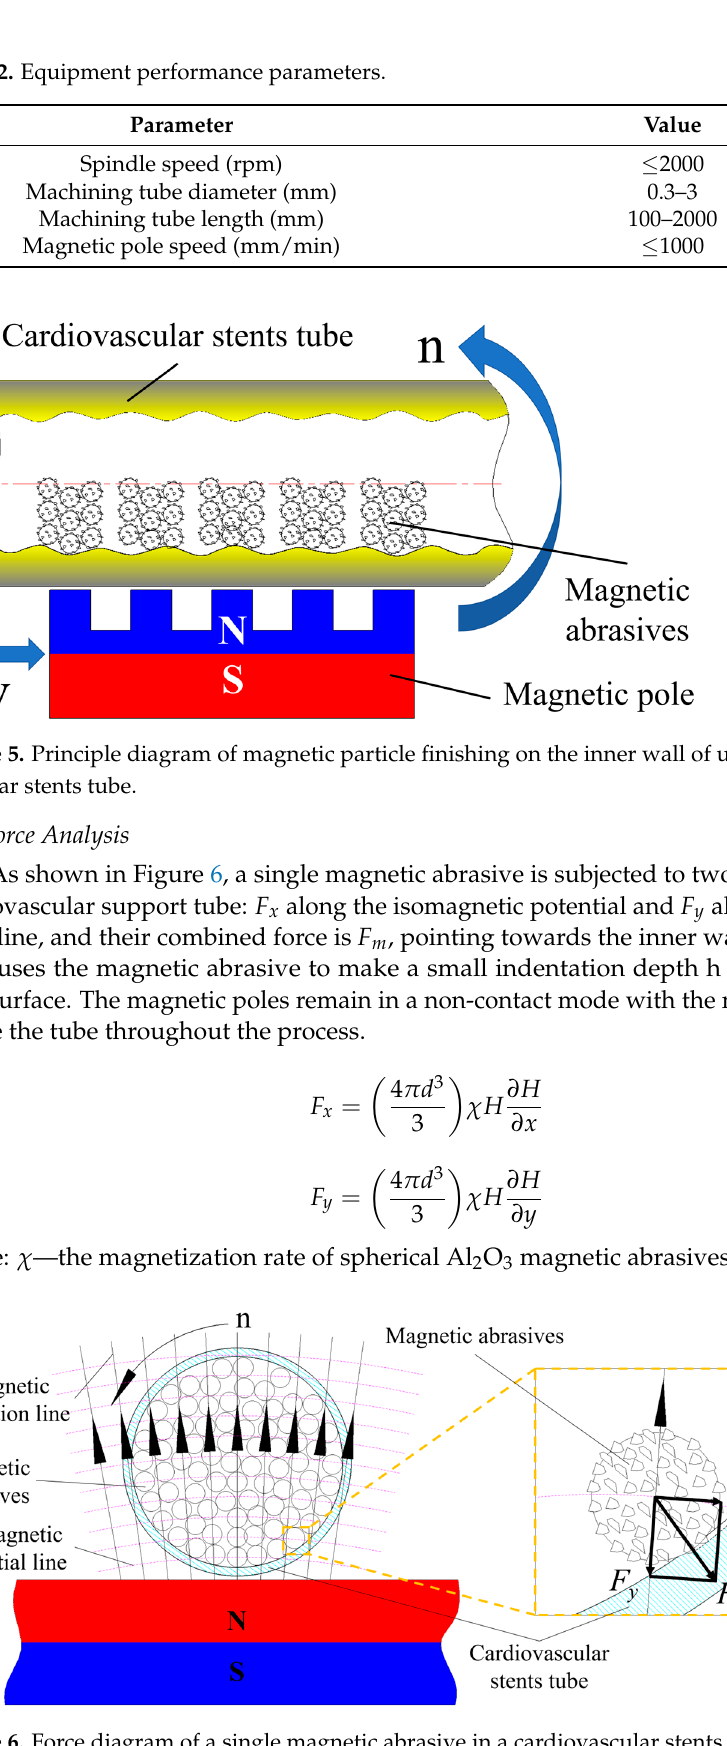
Figure 6. Force diagram of a single magnetic abrasive in a cardiovascular stents tube.